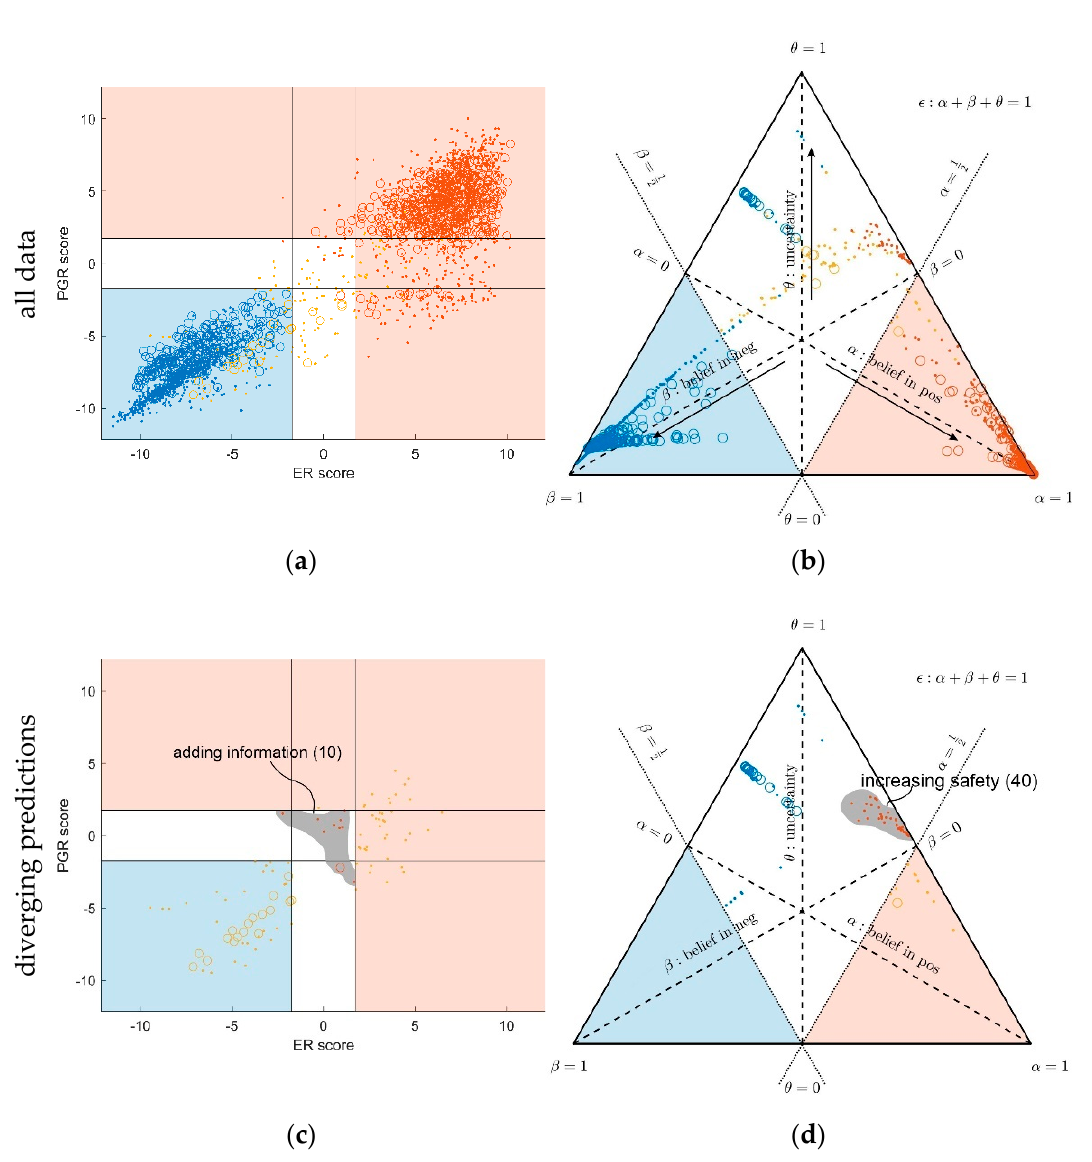
Figure 6. Hormone receptor status classified by ODDS versus Decision Theory. The same patient data were classified twice, along ODDS (left panels) and DST (right panels), for comparison. Data are shown as open circles if at least one IHC status is unknown. All other IHC statuses are shown as dots. Panels ( a , b ) include all 2519 patients of the cohort while panels ( c , d ) only display those 95 patients with predictions diverging between ODDS and DST, for easy comparison. Note the legends highlighting those patient samples which benefit from enhanced information or safety, respectively, conferred by DST. ( Left panels ): sample data arranged according to orthogonal ODDS score axes, but colored according to DST prediction. Light blue area: negative by ODDS. Light red area: positive. White L-shaped area: inconclusive by ODDS. ( Right panels ): sample data arranged according to ternary DST evidence axes, but colored according to ODDS prediction. Light blue triangle: negative by DST. Light red triangle: positive by DST. White kite-shaped area: inconclusive by DST. ( Lower panels ): only patients with diverging predictions are shown. Note two important groups marked by legends, corresponding to two cells in Table 1.